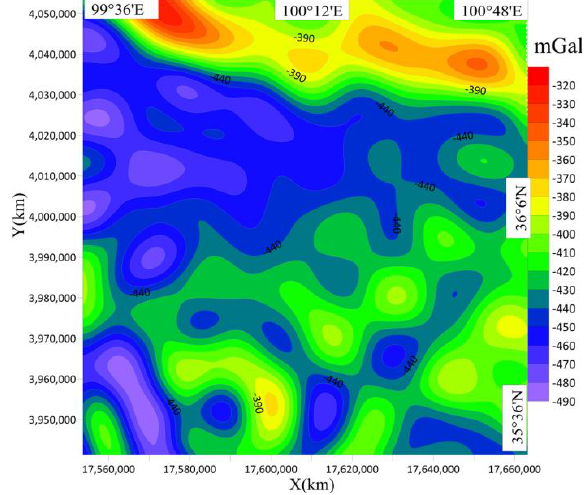
Figure 3. Satellite Bouguer gravity anomaly map in the study area.